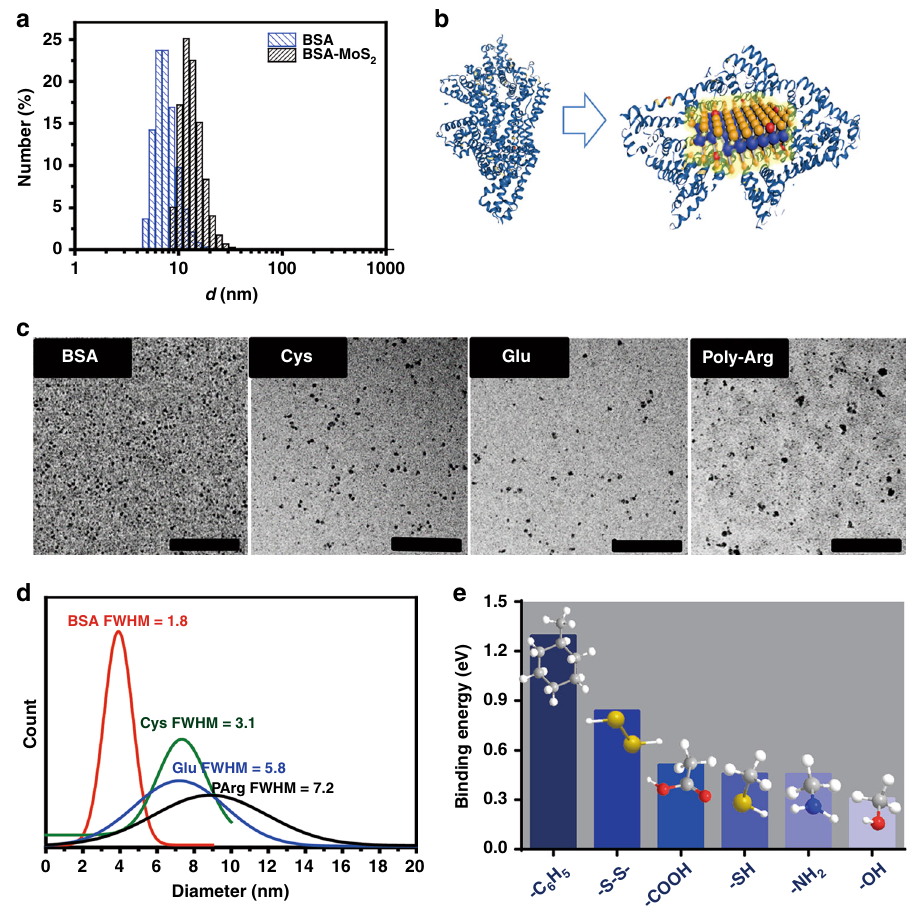
Fig. 2 Surfactant effect on quality of MoS 2 QDs. a Size of the BSA and MoS 2 QDs determined by DLS. b Schematic illustration of possible BSA interactions with one MoS 2 QD. c TEM images of MoS 2 QDs synthesized with BSA, Cys, Glu and Poly-Arg. Scale bar: 200 nm. d Statistical analysis of the size distributions of MoS 2 QDs synthesized with different biological surfactants. e Binding energy of major functional groups of BSA to MoS 2